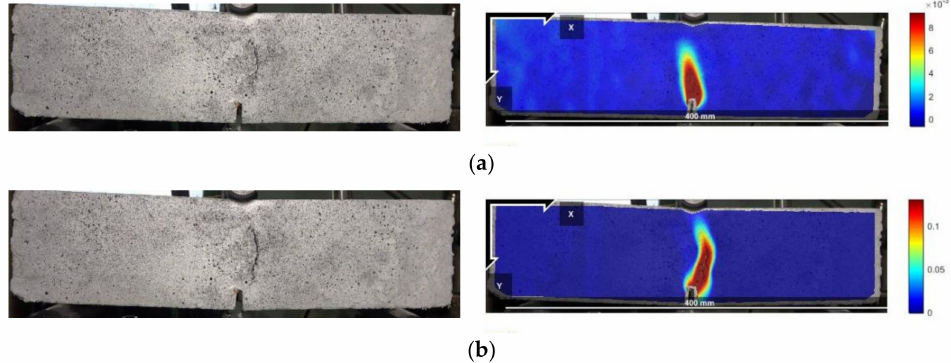
Figure 5. Failure process (left) and DIC strain field (right) of the H 8 S 0 specimen. ( a ) Peak value; ( b ) CMOD = 3.5